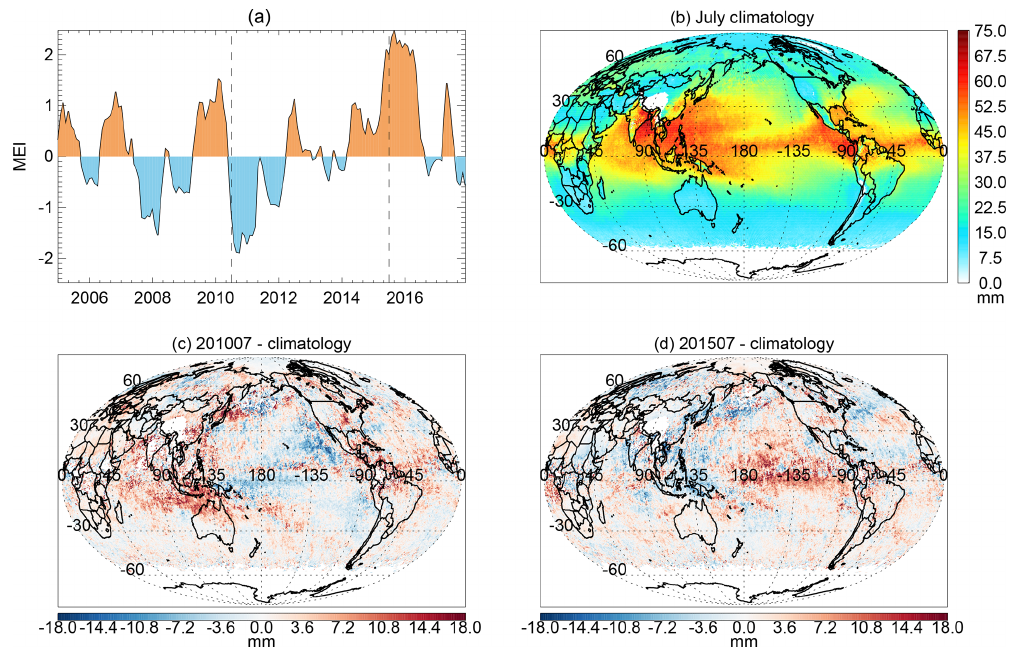
Figure 7. (a) Multivariate ENSO index. Dashed vertical lines indicate July 2010 and July 2015. (b) TCWV (mm) climatology for July derived from version 4.0 OMI data. TCWV anomaly (mm) with respect to the climatology for (c) July 2010 and (d) July